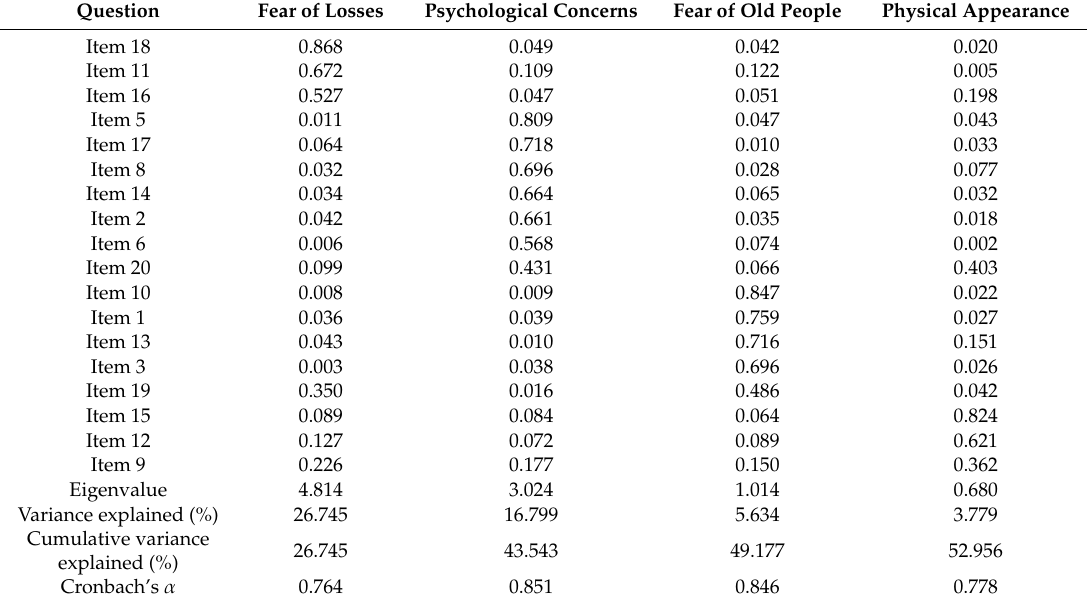
Table 3. Exploratory factor analysis of aging anxiety.